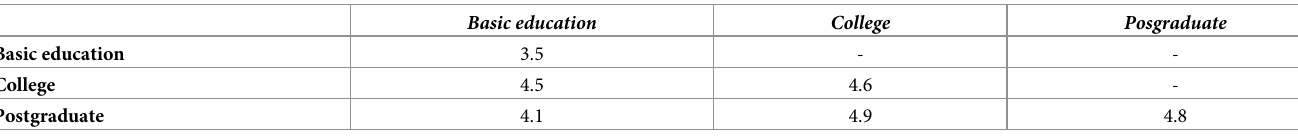
Table 6. Understanding of TE according to the academic level of the